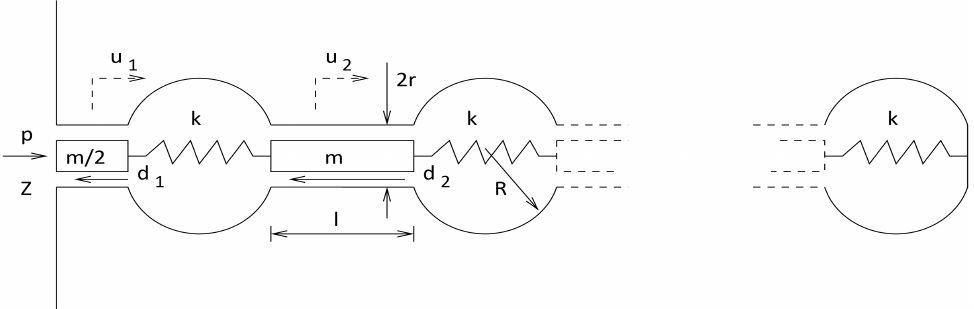
Figure 4. Labyrinthine Resonator